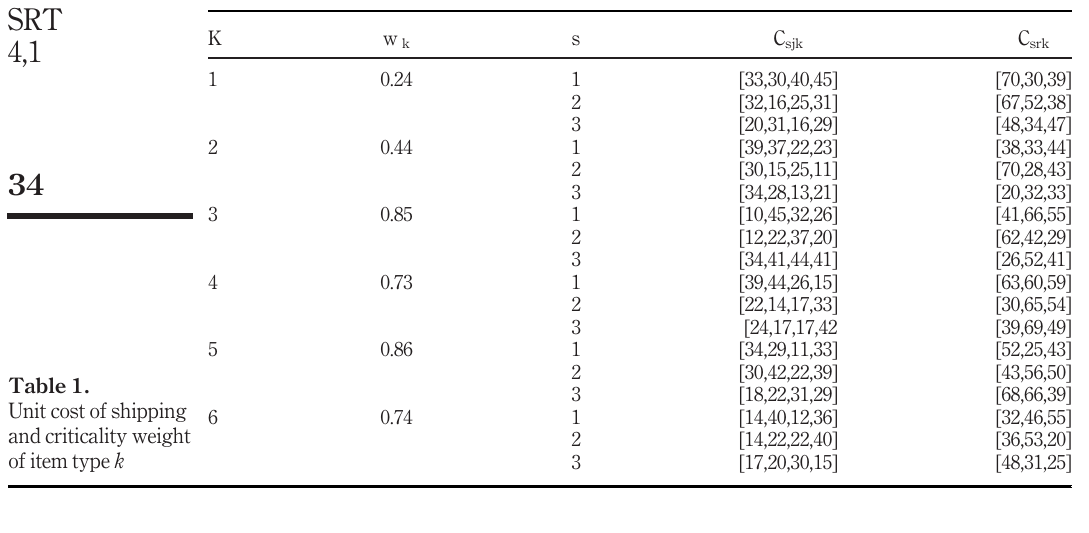
Table 2. D sk expected demand for item type k in scenario s